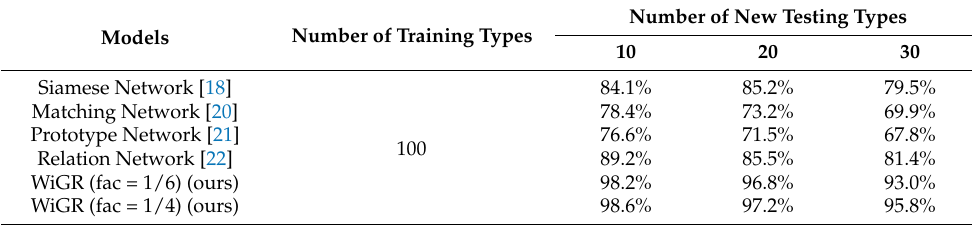
Table 5. Accuracy of recognizing new types of gestures with three samples using the SignFi data set.